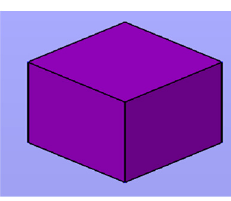
Figure 1. Diagram of research design and workflow. In this workflow, a geometric model was imported into a simulation environment and processed into numerical values.